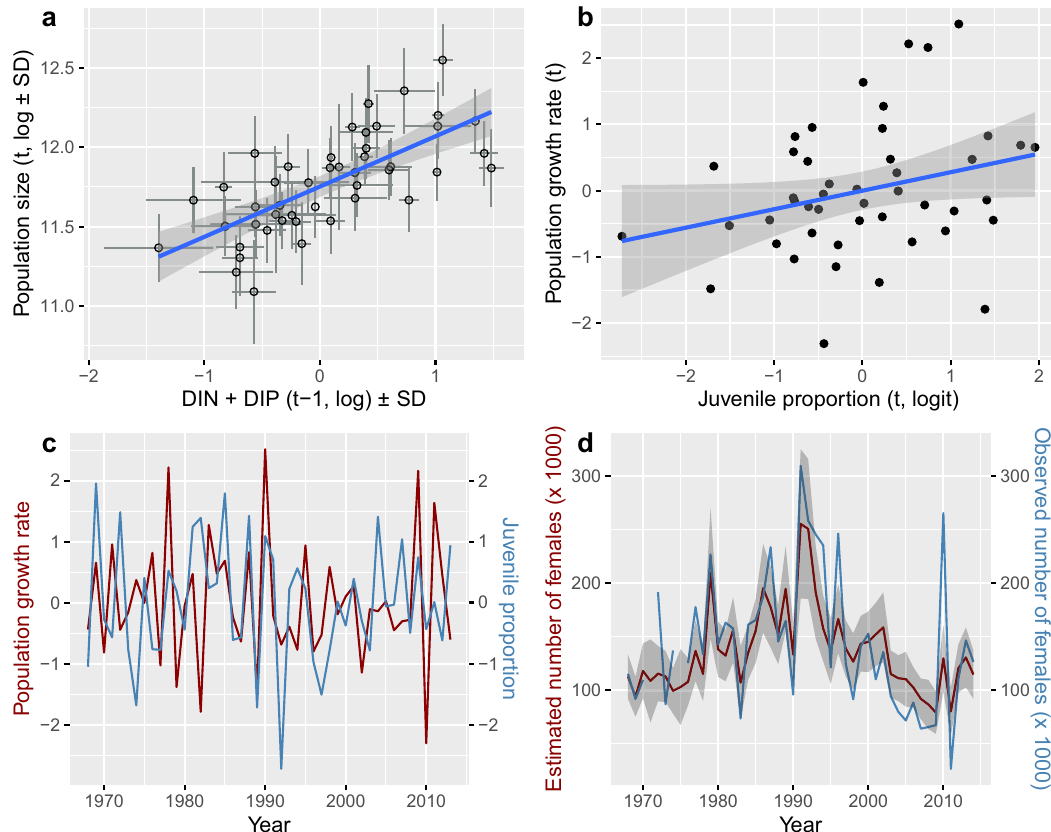
Figure 4. ( a ) Joint effect of (weighted) DIN and DIP (dissolved inorganic nitrogen and phosphorus) in the previous year on long-tailed duck state population size from spring migration counts at the Söderskär observatory. Nutrient amounts were measured in the southern Baltic Sea and their joint effect was calculated − 1 ∗ DIP ( t − 1 ) with the formulation ( 1 − w D ) DIN ( t − 1 ) + w D designed for estimation with Eq. (4). ( b ) The (cid:31) (cid:30) effect of juvenile proportions estimated using Eq. (2) based on wing data from Danish hunting returns on the population growth rate ( t ) = n ( t + 1 ) − n ( t ) of long-tailed ducks estimated using Eq. (4), and ( c ) the trajectories of these during 1968–2013. Values are scaled to mean zero and unit variance. ( d ) Observed and predicted numbers of spring migrating female long-tailed ducks at Söderskär. Population estimates and confidence interval are calculated using a hierarchical state-space model as given in Eq. for May over June (Supplementary Table S1b), had a stronger effect than the temperature variable (Fig. 3b). Together the North-west Siberian climate variables explained 26% of the total variation in juvenile proportions. The proportion of juveniles declined the year following lemming peaks (Fig. 3c), implying that lemming popula- tion troughs that followed high abundance peaks were poor years for long-tailed duck recruitment. Lemming population variation explained 9% of juvenile proportions (Supplementary Table S1b). High NAOI was followed by declines in juvenile proportion with a three-year lag (Fig. 3d), suggesting poor recruitment three years after a warm winter. Together, the climate parameters (Fig. 3) explained 39% of the total variance estimated for the long-tailed duck juvenile proportion (Supplementary Table S1b). Long-tailed duck spring migration counts as estimated with Eq. (4) increased with increasing DIN and decreasing DIP in the southern Baltic Sea in the previous year (24% variance partition proportion for the joint effect with high statistical confidence, Supplementary Table S1c). The weighting parameter w D (= 0.49) sug- gested similar effect sizes for DIN and DIP. Figure 4a shows the joint effect. Increases in juvenile proportions in autumn and winter, i.e. R ( t ) from Eq. (2), were followed by slight increases in numbers of spring-migrating long-tailed ducks n ( t + 1 ) from Eq. (4) (5% variance partition proportion, Supplementary Table S1c). This trend is best illustrated by plotting annual population growth rates, n ( t + 1 ) − n ( t ) , against R ( t ) , although this relationship is noisy (Fig. 4b,c) with parameter distribution skewed rightward: P ( β R > 0.05) = 0.9 (mean of β R = 0.25 ± 0.17 SD ). Density-dependent population regulation of the long-tailed duck was observed (22% variance partition proportion). The observation process variation ( i.e. , sampling error or observation error) of spring migration counts was affected by east–west aspect winds such that observed counts decreased with strengthening west winds during the annual census period. The details of wind effects on the observations, which delineated the performance of the population model given in Eq. (4), are reported in Supplementary Methods. After correcting for measurement